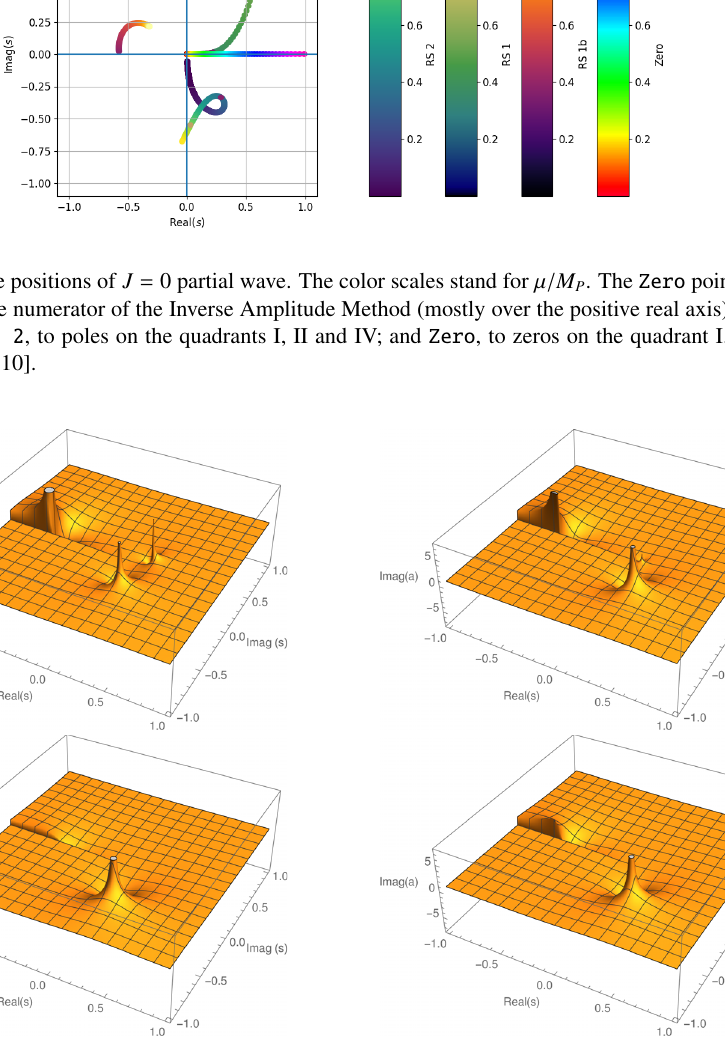
Figure 2. From top left, clockwise: plots of Im a IAM disappearance of the poles on the first Riemann sheet (quadrants I and II). Figure from our ref.